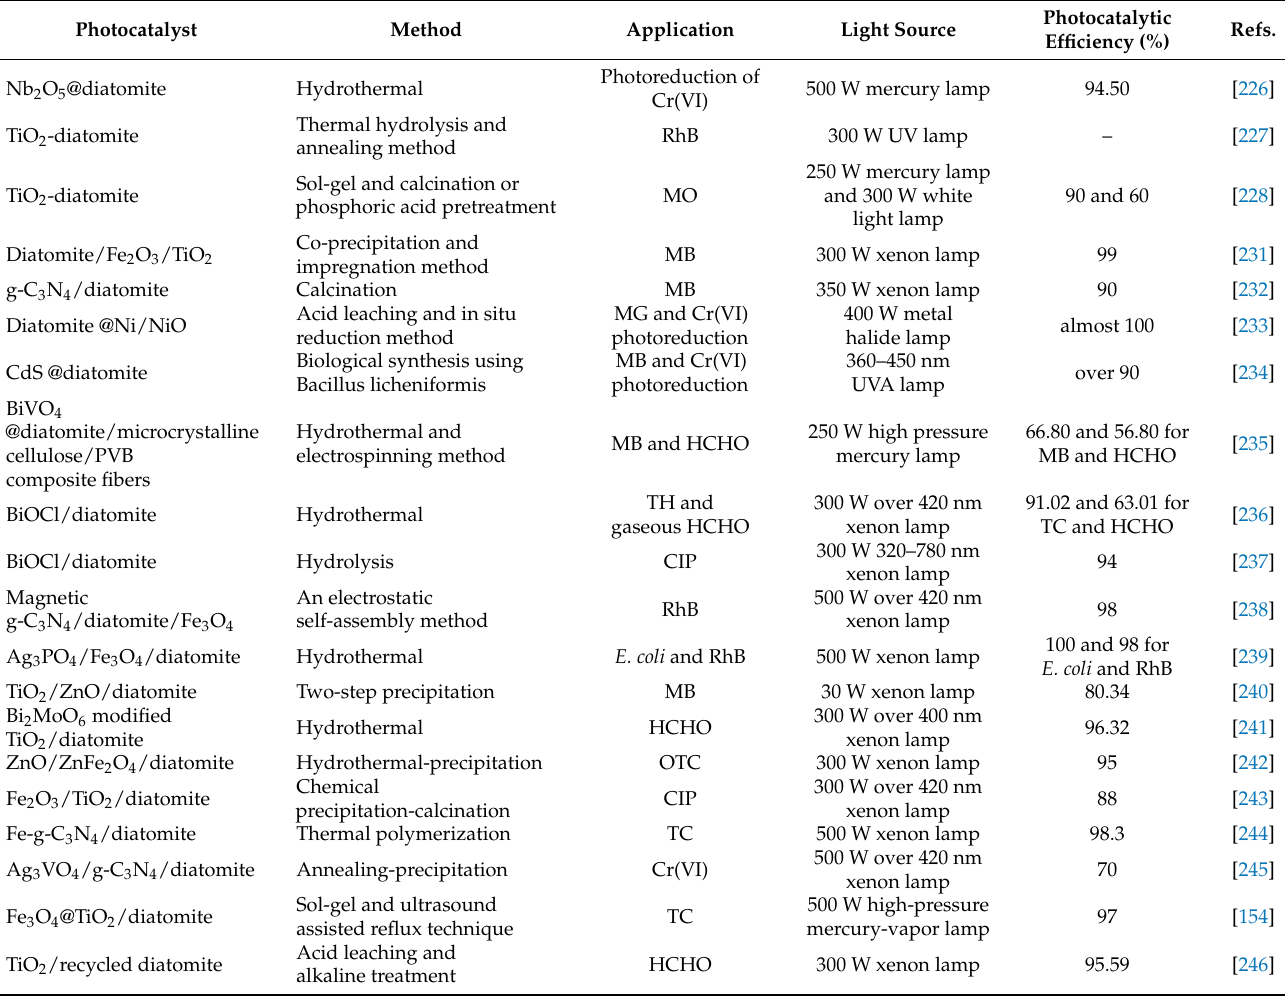
Figure 10. ( a ) SEM images of raw diatomite sample; ( b ) schematic of the fabrication of g − C 3 N 4 /diatomite composites. Photos of selective removal of various dyes. Proposed reaction mechanism for methylene blue (MB) decomposition over g − C 3 N 4 /diatomite − 2.0 photocatalyst. Adapted with permission from Ref. [226]. Copyright 2018, Elsevier B.V; Adapted with permission from Ref. [232]. Copyright 2019, Elsevier B.V. Table 3. Applications of various photocatalysts using natural diatomite as support